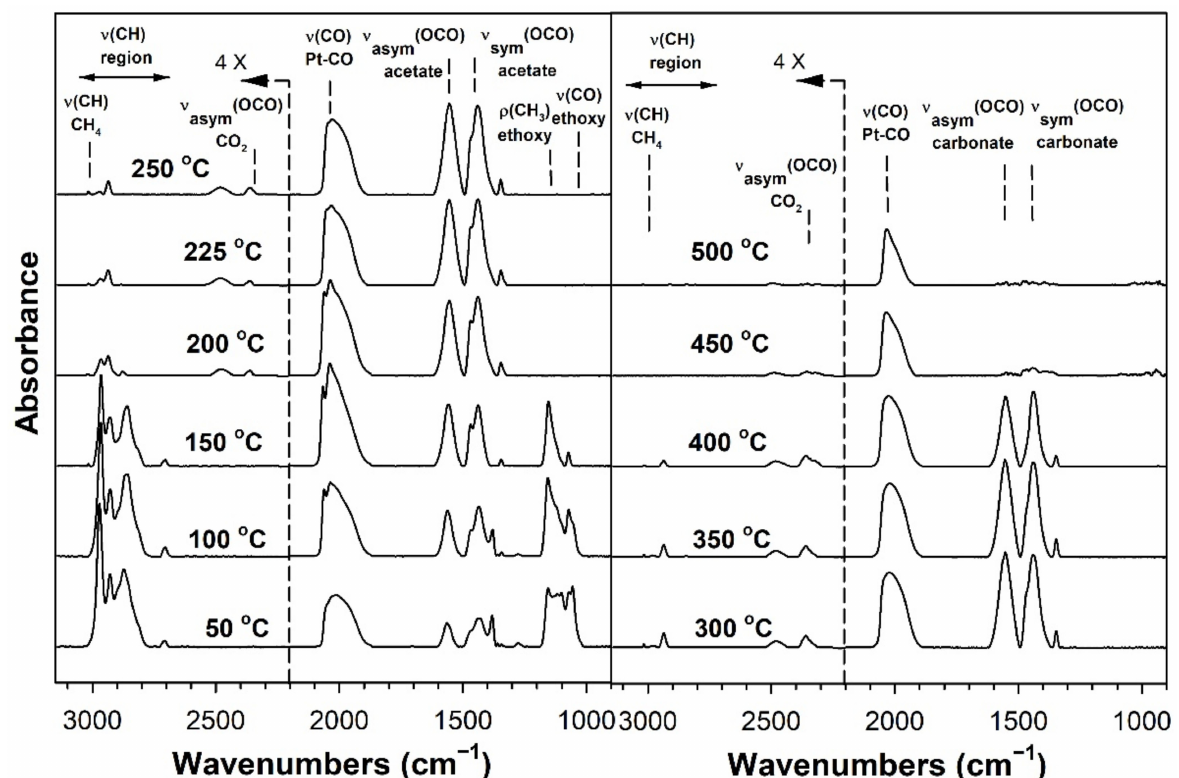
Figure 7. DRIFTS spectra of transient ESR over 4.25% K-2% Pt/m-ZrO 2 .